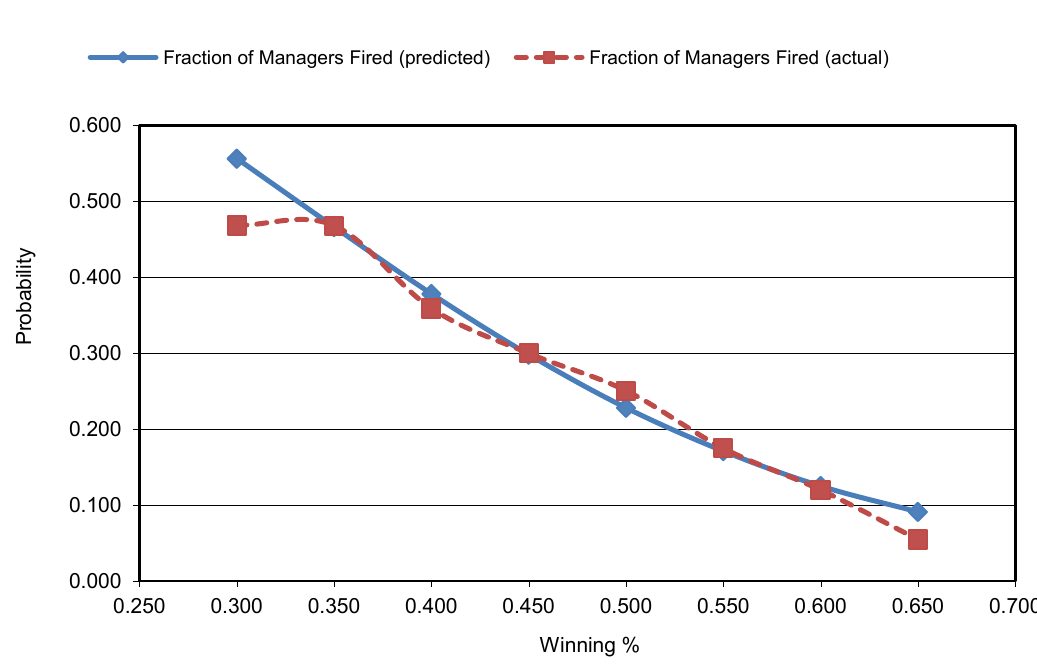
Figure 1: Probability that a Major League Baseball manager will be fired. Figure 2. Probability that an ex-Major League Baseball manager will be hired